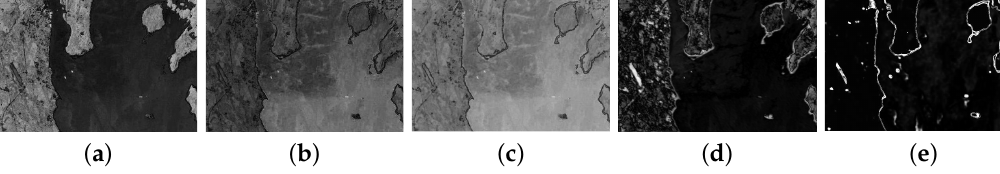
Figure 23. The DIs generated by different methods in the Campbell River data set: ( a ) subtraction, ( b ) log-ratio, ( c ) wavelet fusion, ( d ) SCCN, and ( e ) DADNN.